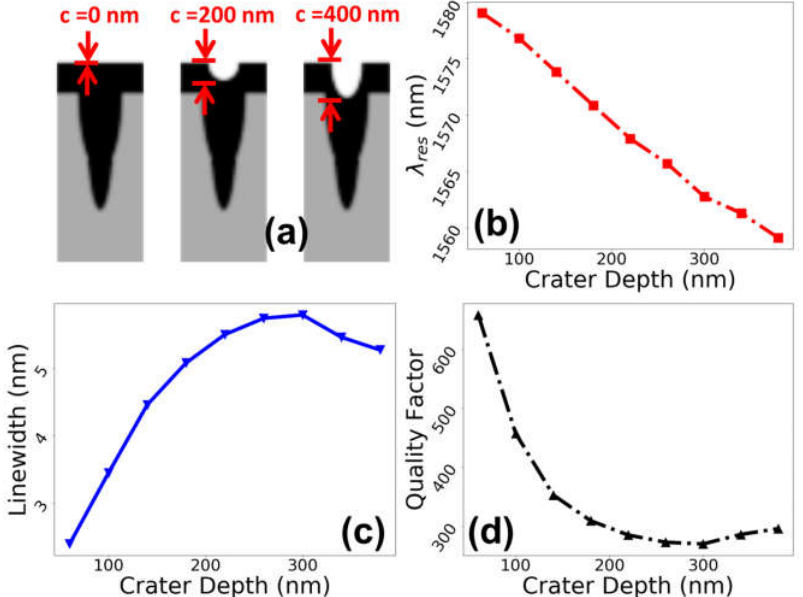
Figure 8. Transmission spectra of PhC-structure with crater-depth varied from 60 to 380 nm. A blueshift along with an increase in the linewidth of the resonant modes can be observed.